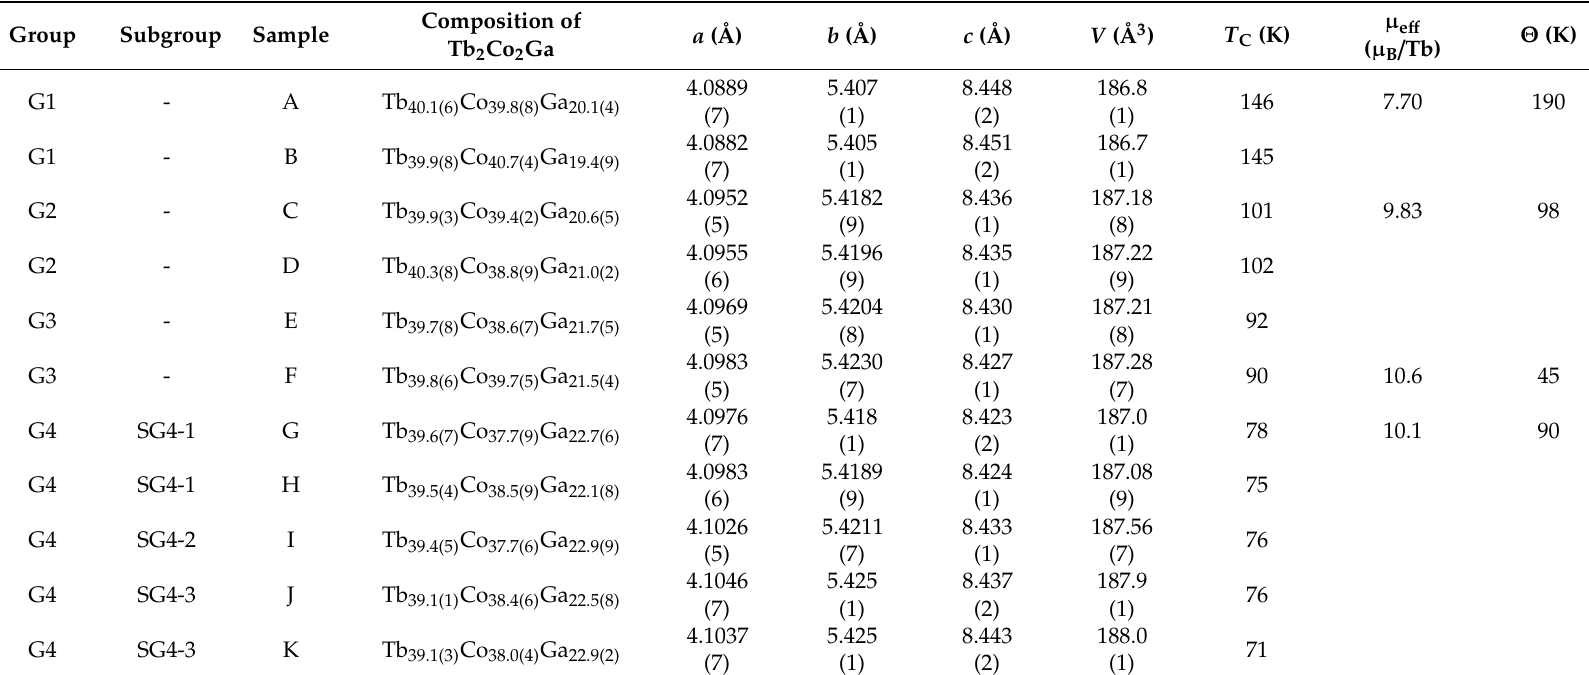
Table 3. Atomic composition, lattice parameters, cell volume V , T C determined by χ ac , µ e ff and Θ of each Tb 2 Co 2 Ga sample.